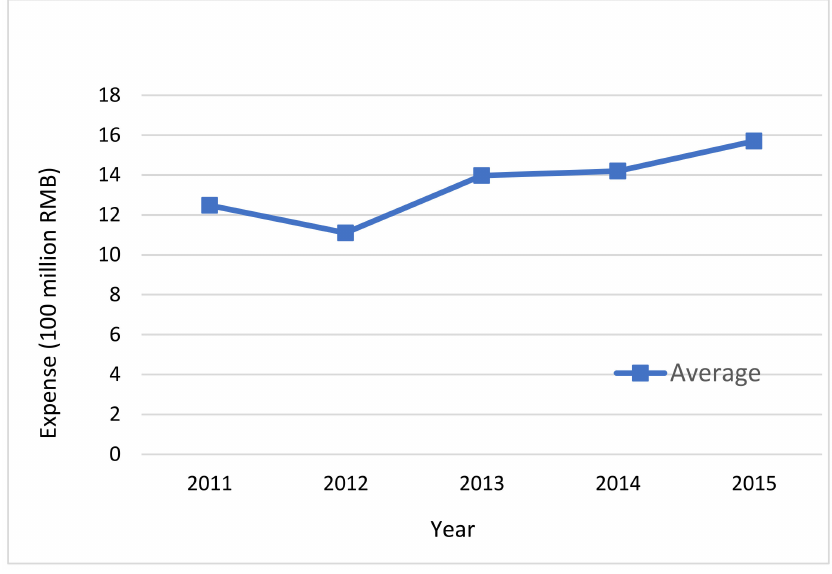
Figure 3. Average wastewater discharge expense over 2011–2015 in China.